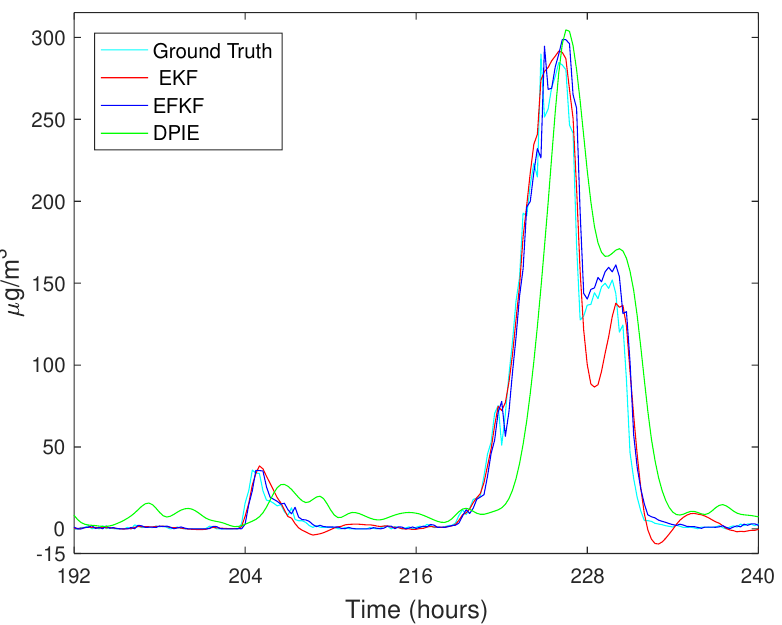
Figure 6. On-site PM2.5 concentration during 18–19 December 2019: ground truth (measured data), DPIE (station data), and estimation using EKF and EFKF.